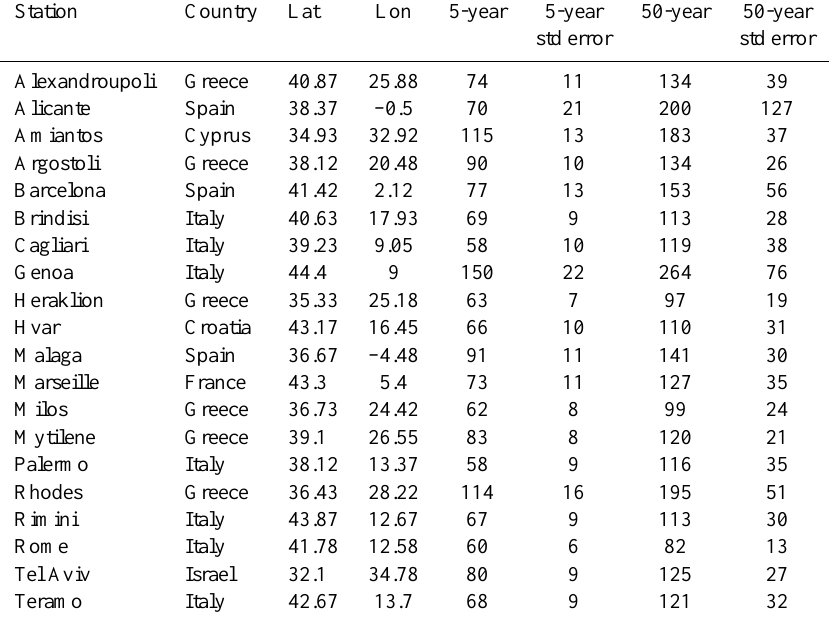
Table 1. Name, country and geographical coordinates (latitude and longitude) of the 20stations. 5 and 50-year return levels and associated uncertainties, values in